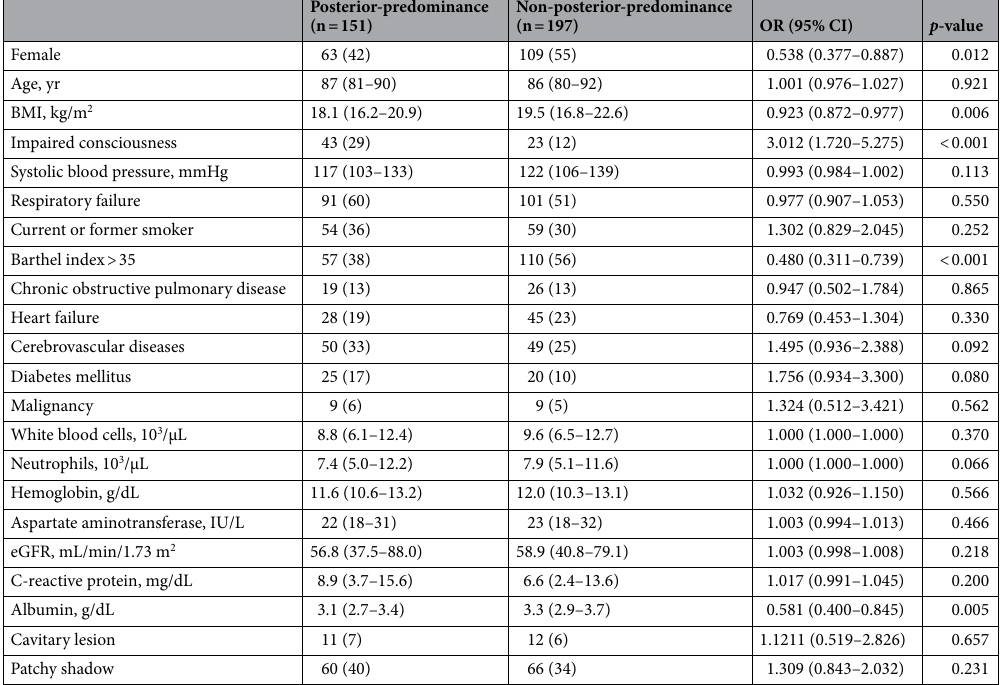
Table 3. Univariate logistic regression analysis of the baseline characteristics associated with posterior- predominant distribution. Data are presented as number (%) or median (interquartile range). BMI, body mass index; CI, confidence interval; eGFR, estimated glomerular filtration rate; OR, odds ratio.